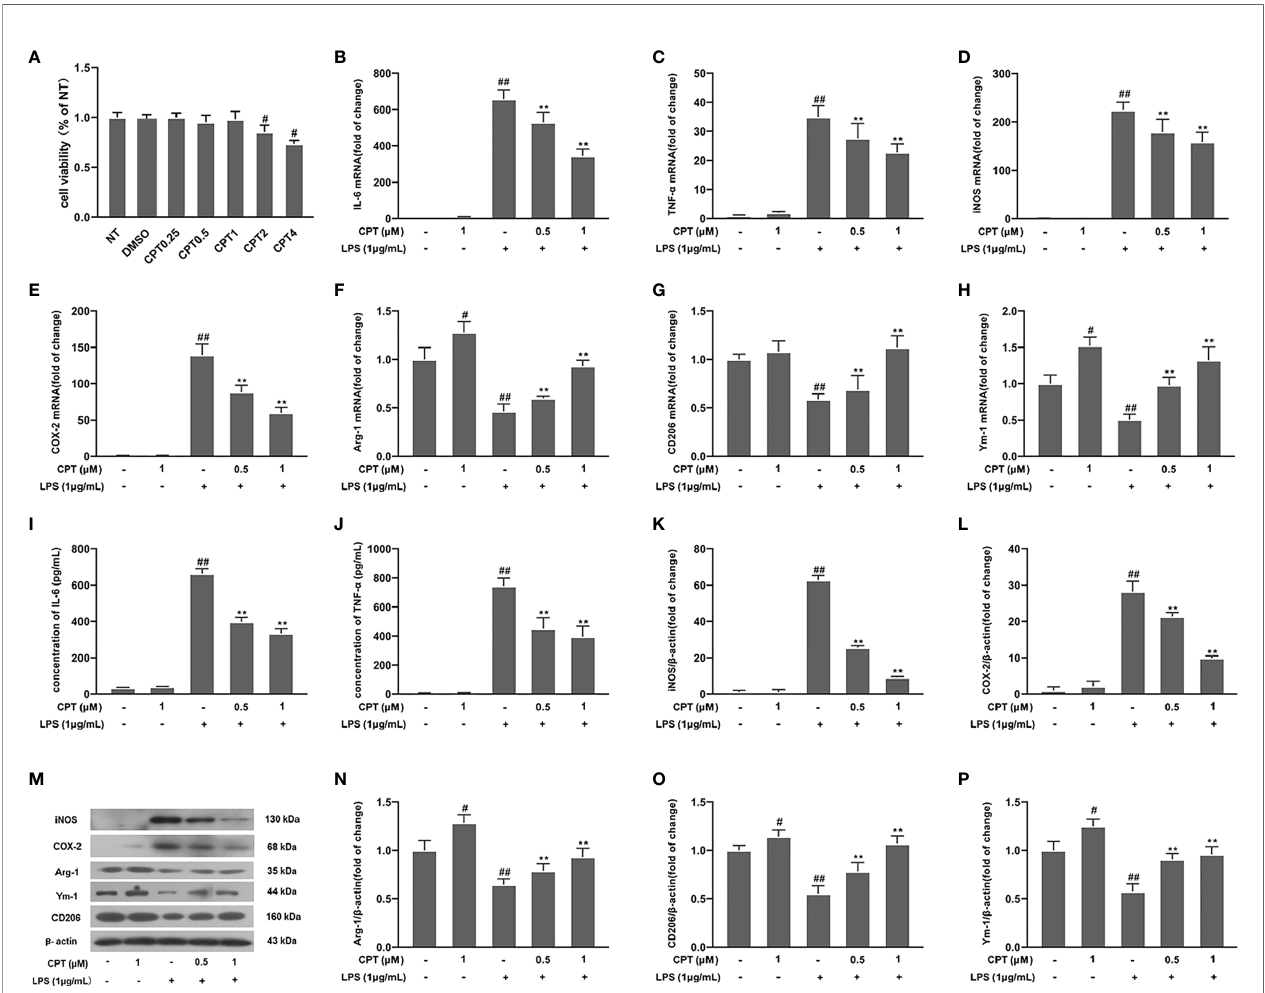
FIGURE 4 | CPT attenuates the in fl ammatory response in LPS-exposed BV-2 cells. (A) The viability of BV-2 cells was measured using CCK-8 assay. The cells were pretreated with CPT (0.5 m M and 1 m M) for 1 h and then treated with LPS (1 m g/mL) for 12 h (mRNA) and 24 h (protein). (B-H) The mRNA levels of M1 microglia markers (IL-6, TNF- a , iNOS, and COX-2) and M2 microglia markers (Ym-1, CD206, and Arg-1) were detected by RT-PCR. (I – P) The protein levels of M1 microglia markers and M2 microglia markers were measured using ELISA (IL-6 and TNF- a ) and western blot (COX-2, iNOS, Arg-1, CD206, and Ym-1). Results are shown as means ± SD (n= 5). # p < 0.5 and ## p < 0.01 vs. the no-treatment (NT) group; **p< 0.01 vs. the LPS-exposed